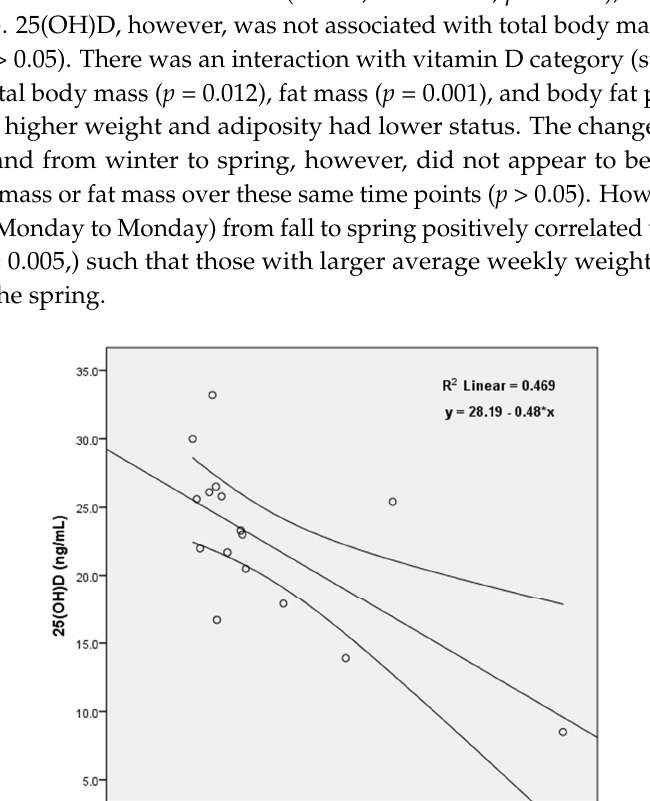
Table 4. Vitamin D intake from food and supplements across the academic year 1 . Vitamin D Source Fall Winter